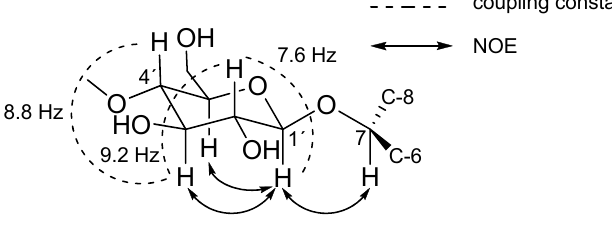
Figure 3. Partial view showing the absolute configuration of 1 .